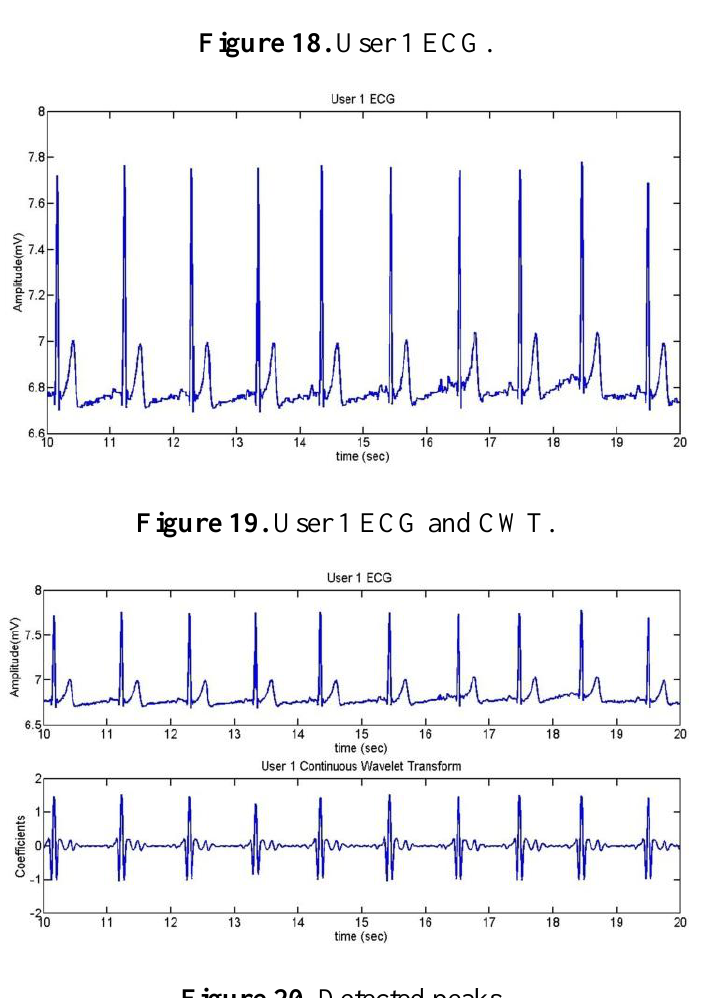
Figure 20. Detected